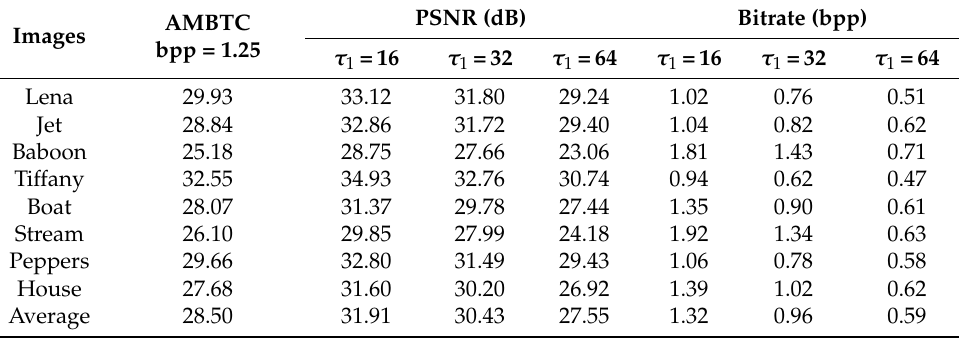
Table 5. PSNR and bitrate of the proposed method for various τ 1 (block size 8 × 8).